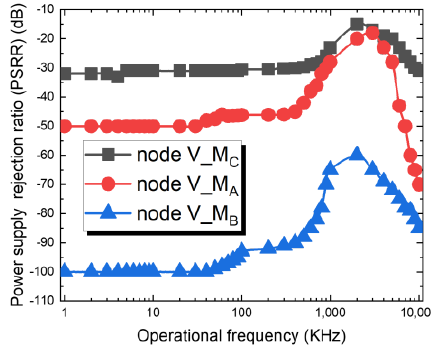
Figure 15. The frequency response of the supply noise in node V_M C , V_M A , and V_M B . The spectrum has bandpass characteristics, and both the low frequency and high frequency noise components are attenuated. The PSRR equation is H(s) = V_M A/B/C (s)/V dd (s), the frequency domain the locations of concomitant poles and zeros, and the resultant contribution of power supply noise to the overall noise properties of the loop.